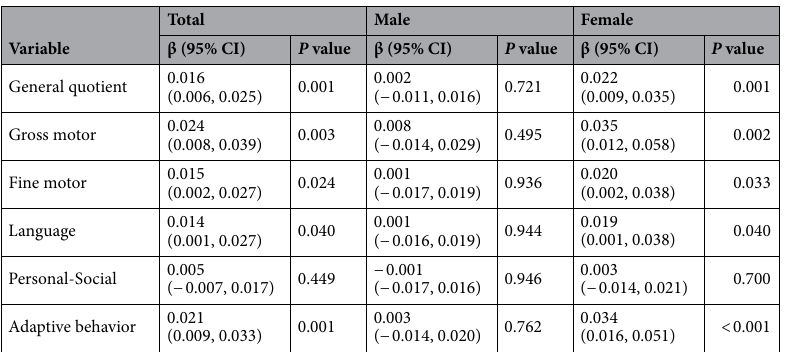
Table 3. Association of serum ferritin levels and developmental function. Linear regression models adjusted for maternal education, parity, feeding at six months, infant age, height, and weight.